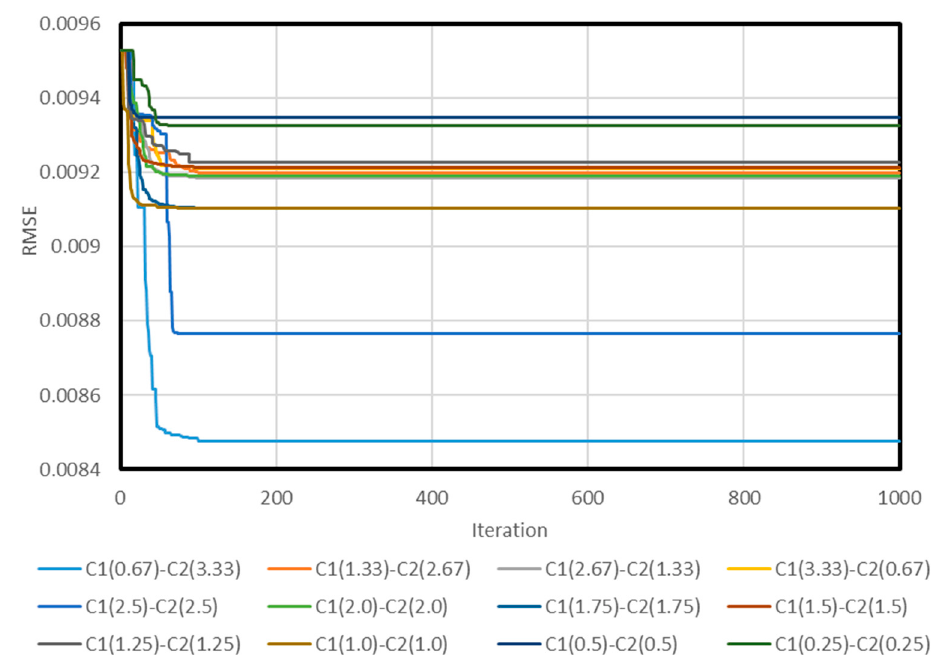
Figure 10. Efficiency results for various personal learning coefficients (C 1 ), as well as global learning coefficient and C 2 amounts.